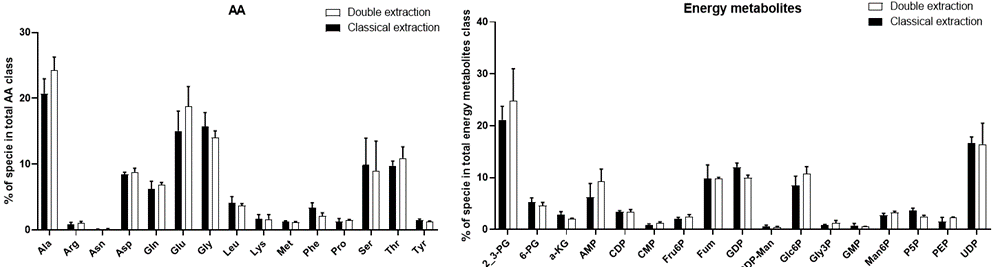
Figure 3. Comparison of the qualitative distribution of amino acids ( AA ) and energy metabolites species for the classical and double extraction methods. Total polar metabolites classes were considered as 100%. Each species corresponds to the percentage of its total polar metabolites classes. Bars represent mean ± SD (n = 5). A Khi2 ( χ 2) test was performed for each class to compare the relative distribution between both methods. No significant differences were observed for alanine (Ala), asparagine (Asp), glutamine (Gln), glutamate (Glu), glycine (Gly), leucine (Leu), serine (Ser), threonine (Thr), phenylalanine (Phe), arginine (Arg), asparagine (Asn), lysine (Lys), methionine (Met), proline (Pro), tyrosine (Tyr), 2,3-bisphosphoglycerate (2_3PG), 6-phosphogluconate (6-PG), a-ketoglutarate (a-KG), adenosine 5 ′ -monophosphate (AMP), cytidine diphosphate (CDP), cytidine 5 ′ -monophosphate (CMP), fructose-6-phosphate (Fru6P), fumarate (Fum), guanosine diphosphate (GDP), guanosine diphosphate mannose (GDP-Man), glucose-6-phosphate (Glc6P), glycerol-3-Phosphate (Gly3P), guanosine 5 ′ -Monophosphate (GMP); mannose-6-phosphate (Man6P), pyridoxal-5-phosphate (P5P), phosphoenolpyruvate (PEP), and uridine diphosphate (UDP).